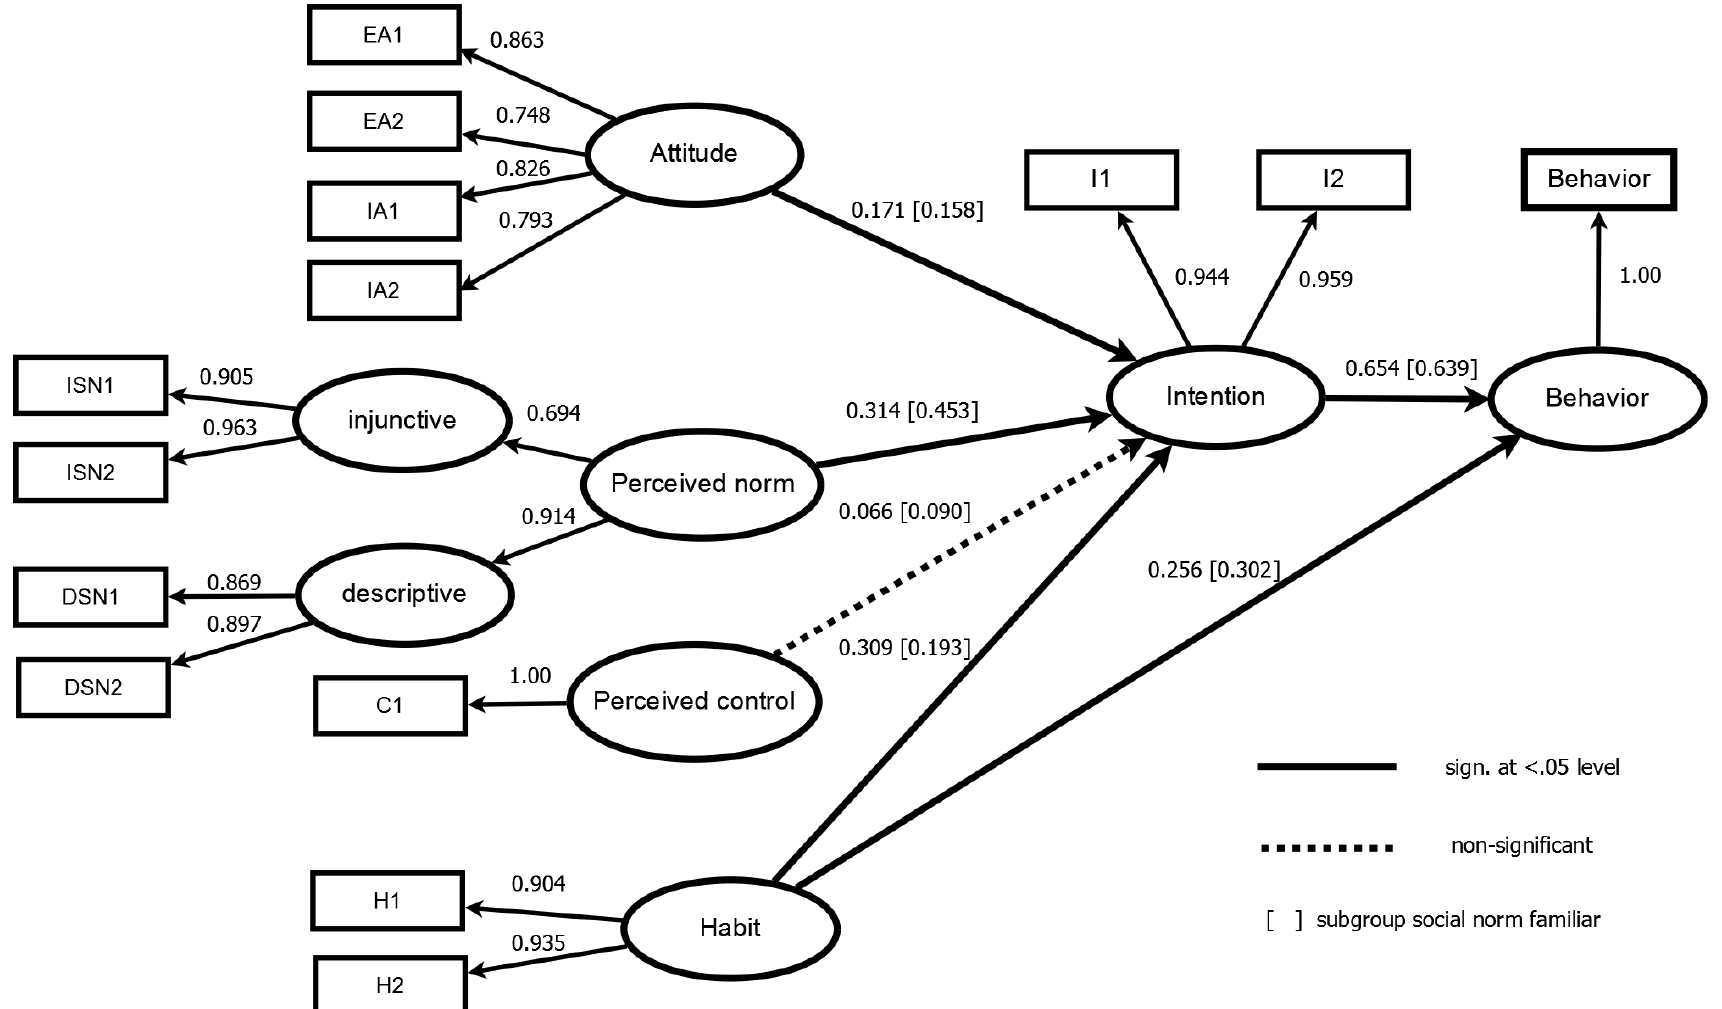
Figure 1. Structural equation model domestic teleconferencing (standardized loadings and path